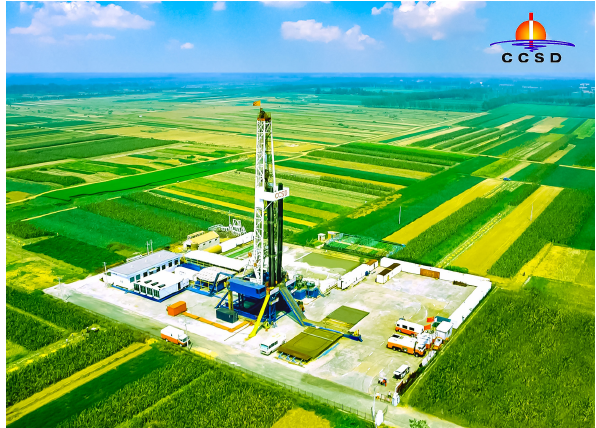
Figure 1. Drilling site of the CCSD-MH atMaobei village in Dong- hai County, Jiangsu Province, eastern China.